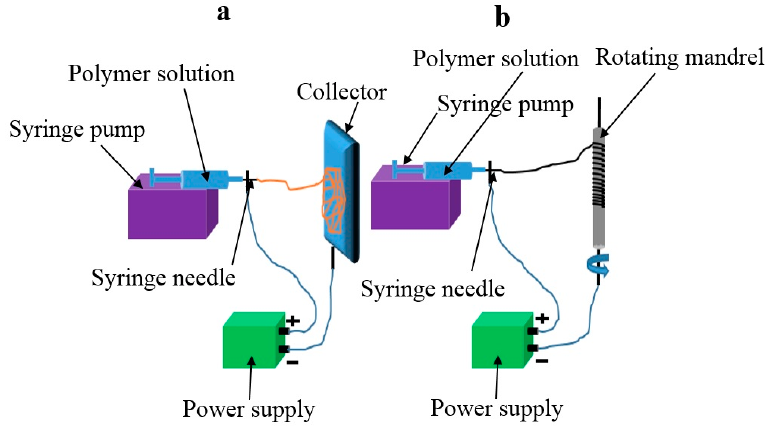
Figure 2. Electrospinning setups: ( a ) grounded flat collector is used to collect fibers; ( b ) tubular rotating mandrel is used to collect fibers to shape blood vessels.